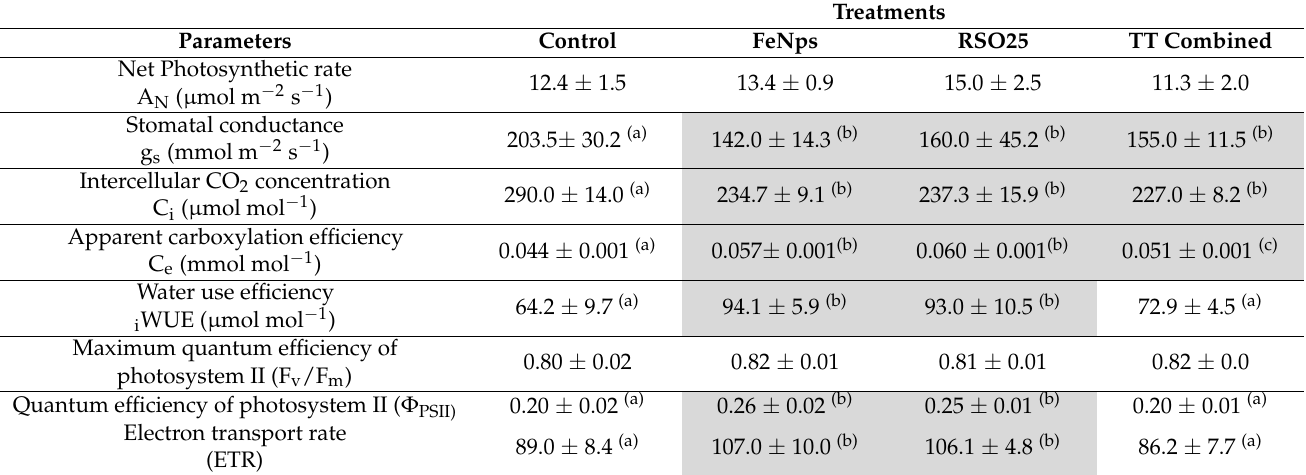
Table 2. Results of different physiological parameters. Net photosynthetic rate (A N ); stomatal conductance (g s ); intercellular CO 2 concentration (C i ); apparent carboxylation efficiency (C e ); intrinsic water use efficiency ( i WUE); maximum quantum efficiency of PSII photochemistry (Fv/Fm); quantum efficiency of PSII ( Φ PSII) and electron transport rate (ETR) in Triticum aestivum plants watered